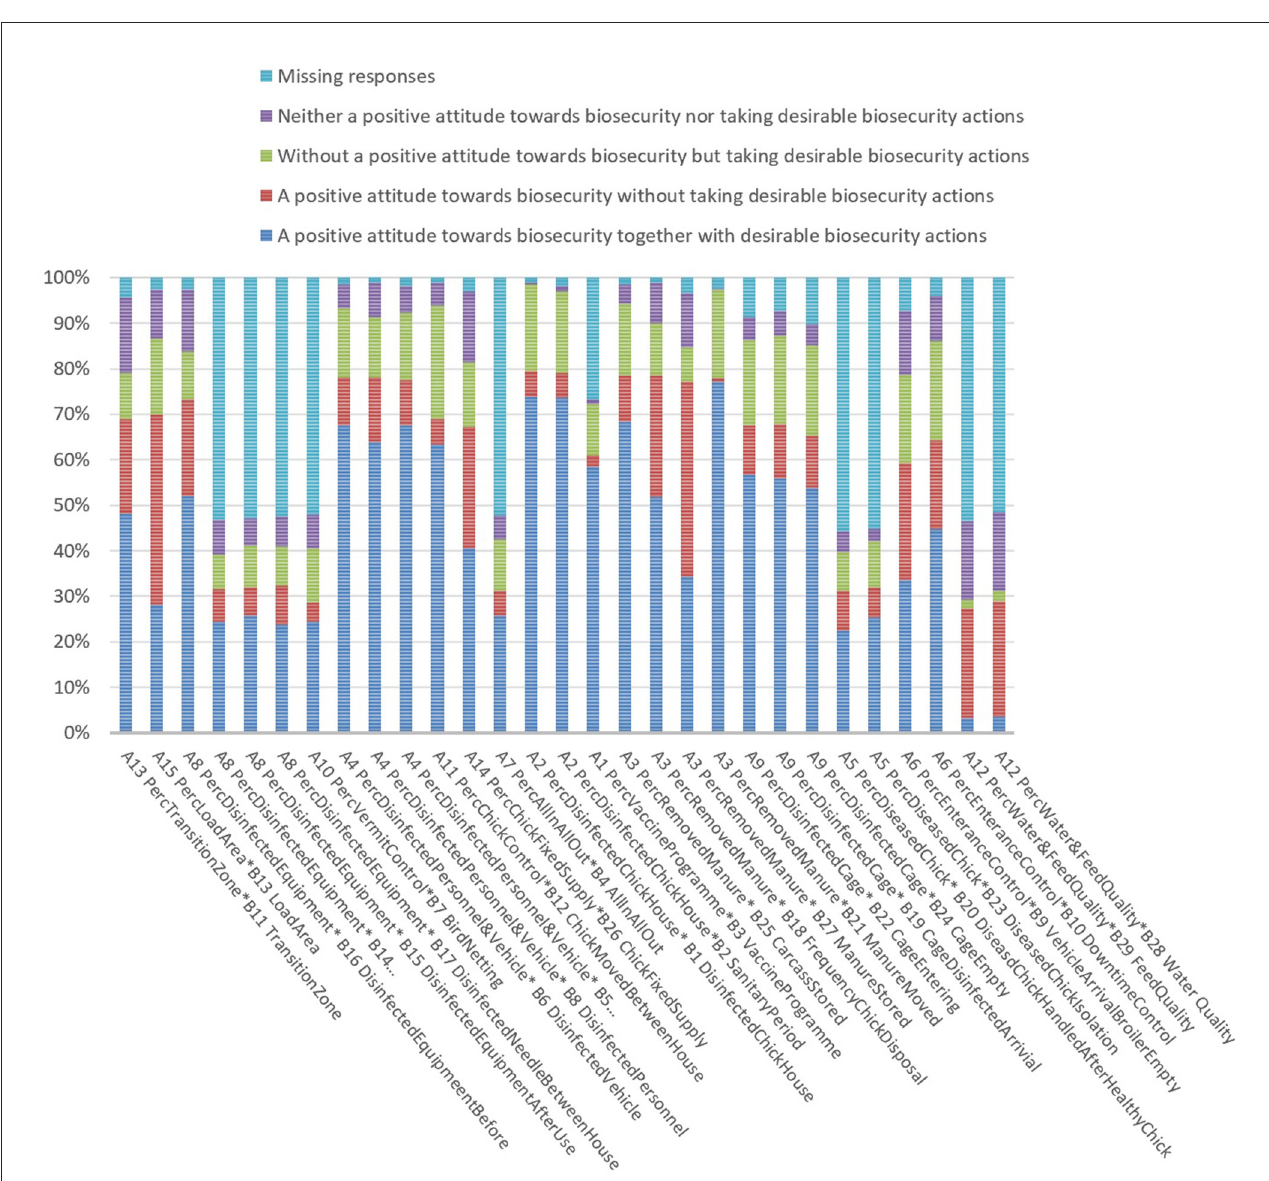
FIGURE3 The variety of the relationships between farmers’ biosecurity attitudes and relevant behaviours. While some farmers tended not to translate their knowledge into the relevant biosecurity actions despite recognising the importance of biosecurity measures, a number of farmers still took desirable biosecurity actions despite not having a positive attitude towards the importance of